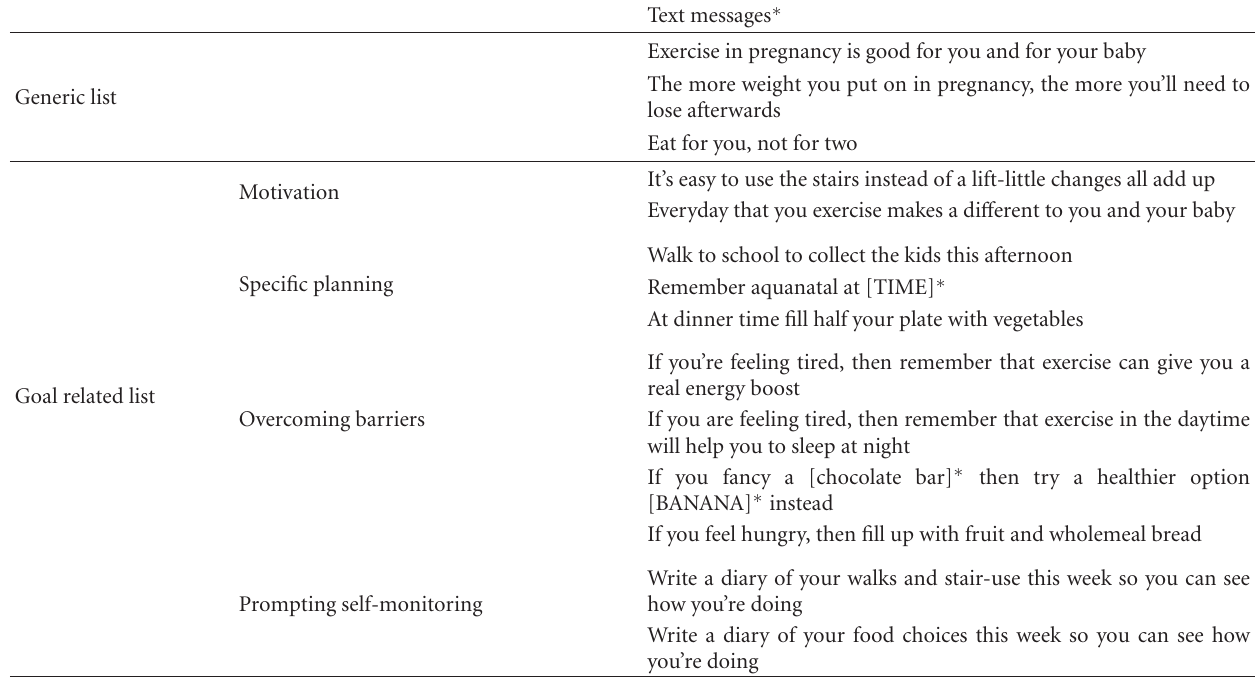
Table 2: Examples of text